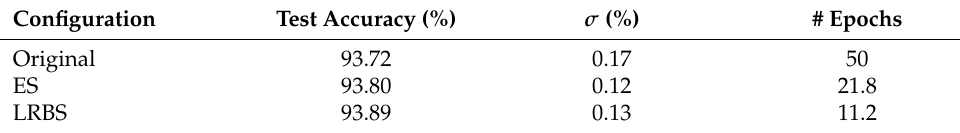
Table 8. Results on MedMNIST2D OCTMNIST dataset in maximum 50 epochs.